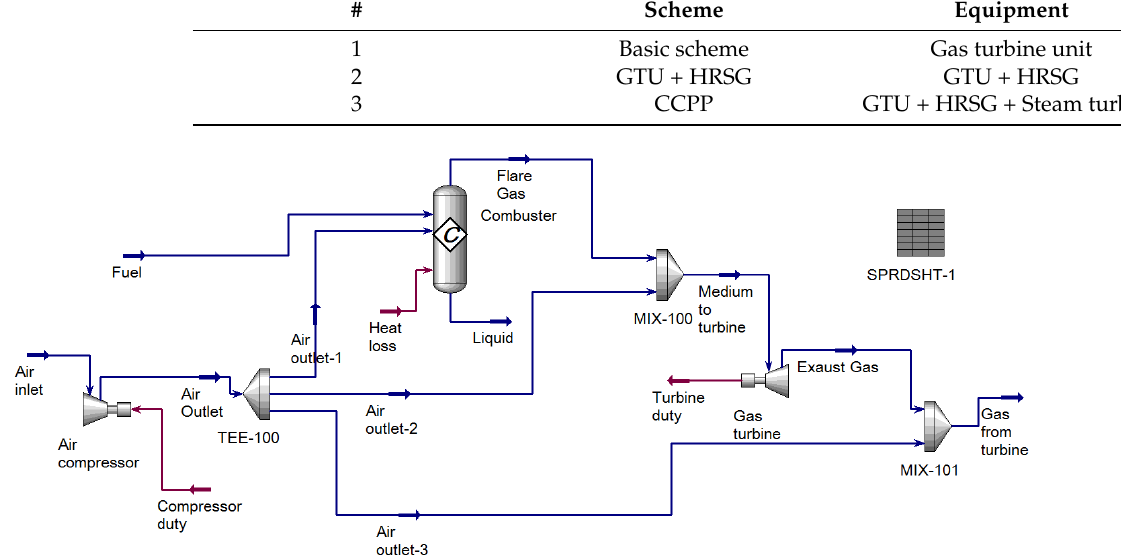
Figure 3. Calculation scheme of a simple GTU cycle synthesized in Aspen HYSYS.